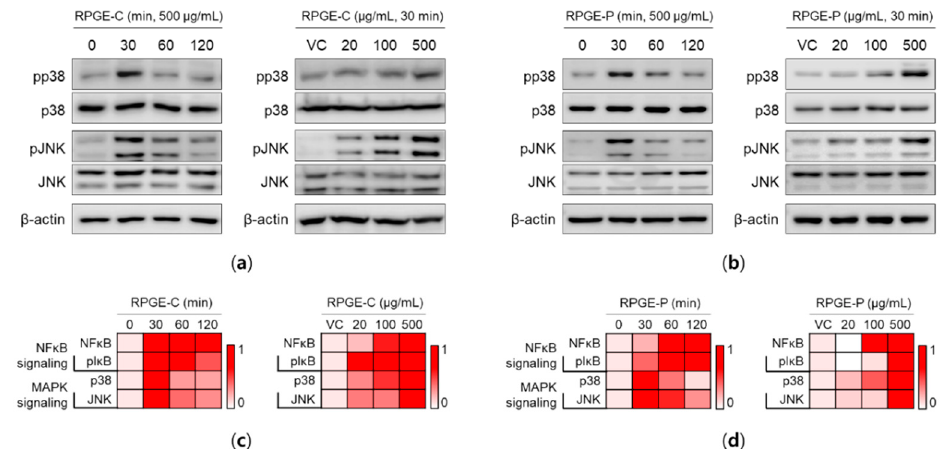
Figure 6. Effect of RPGE on MAPK signaling in RAW 264.7 cells. ( a ) The cells were treated with 500 μ g/mL of RPGE-C for the indicated times or indicated concentrations for 60 min prior to Western blot analysis; ( b ) The cells were treated with 500 μ g/mL of RPGE-P for the indicated times or indicated concentrations for 60 min prior to Western blot analysis; ( c ) The time–response and concentration– response relationships of RPGE-C were represented as heat maps. ( d ) The time–response and concentration–response relationships of RPGE-P were represented as heat maps.